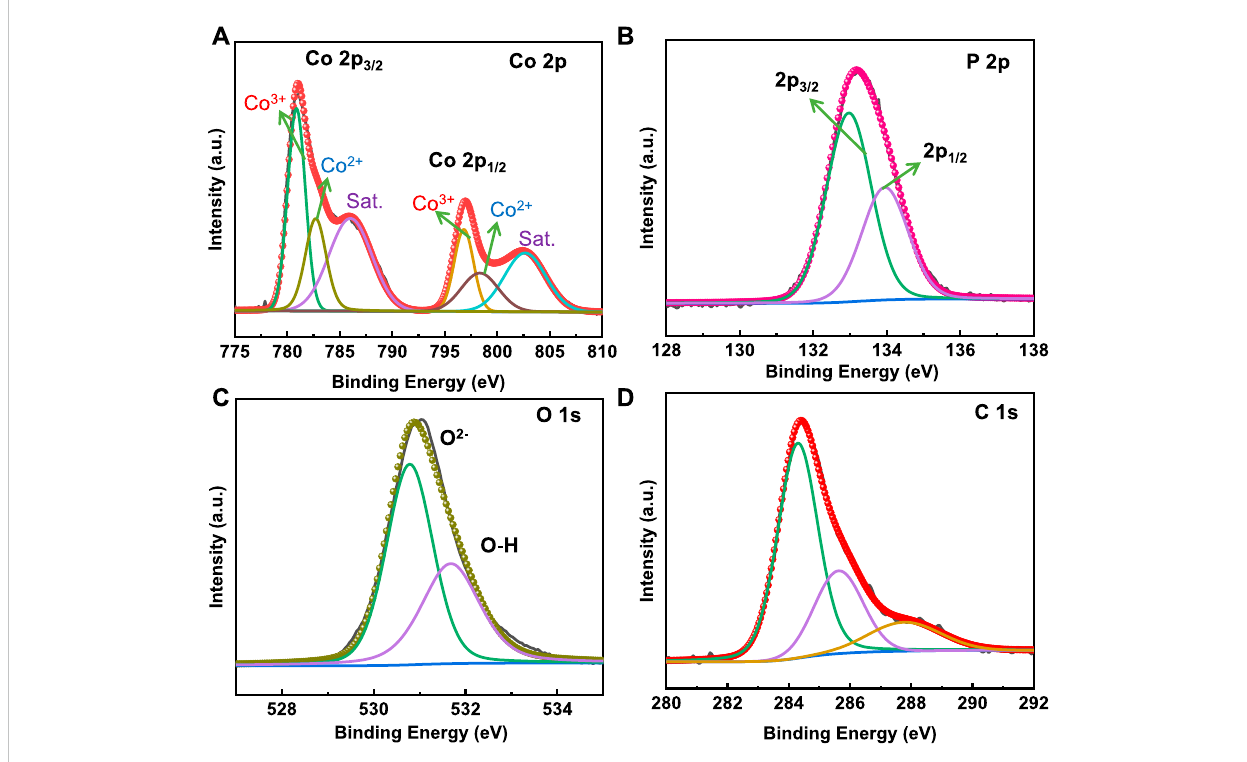
FIGURE 6 High-resolution deconvoluted XPS spectra of (A) Co 2p, (B) P 2p, (C) O 1s, and (D) C 1s energy levels in the Co 3 (PO 4 ) 2 .8H 2 O/CNF composite